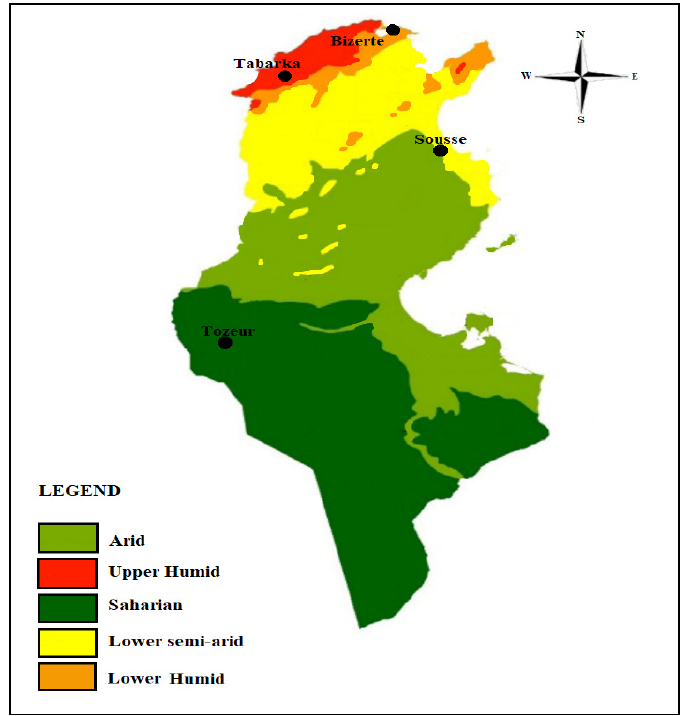
Figure 3. Map of climatic zones in Tunisia. Table 1. Considered cities located in di ff erent climatic zones.